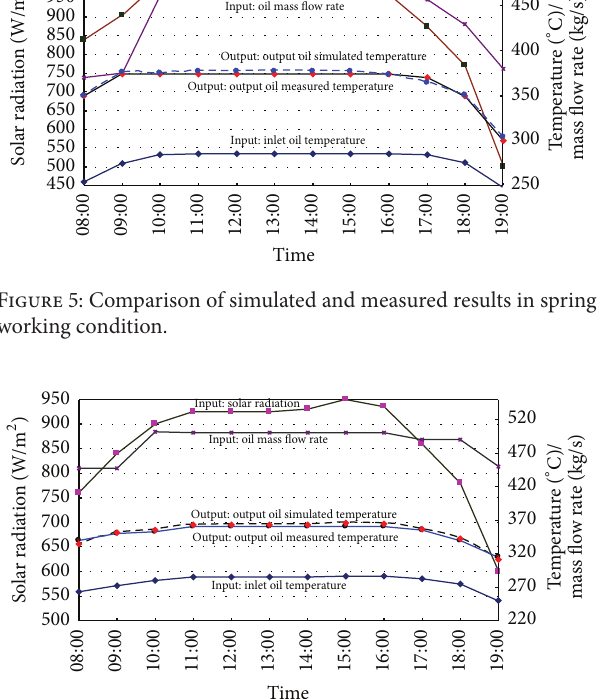
Table 2: Main physical and chemical characteristics of THERMI- NOL VP-1 [4].